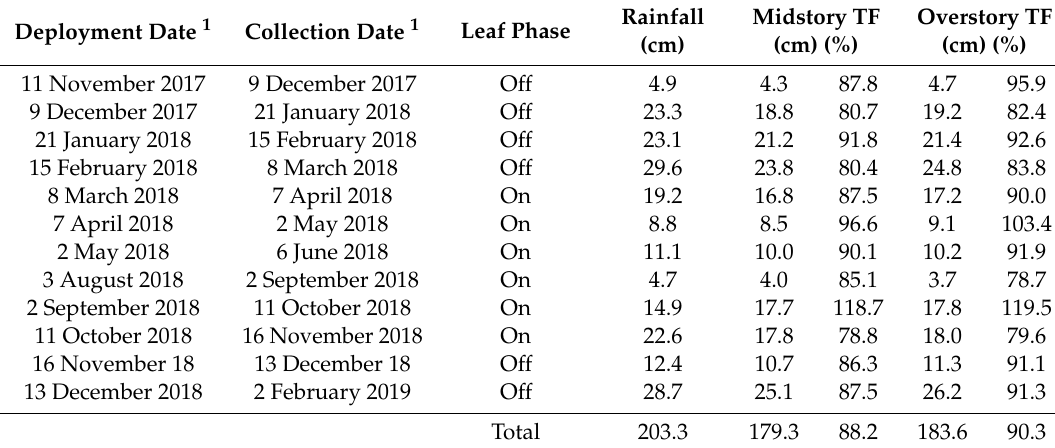
Table 2. Summary of rainfall depth and midstory and overstory throughfall depth and percent of total rainfall collected in approximately 4-week intervals over the study